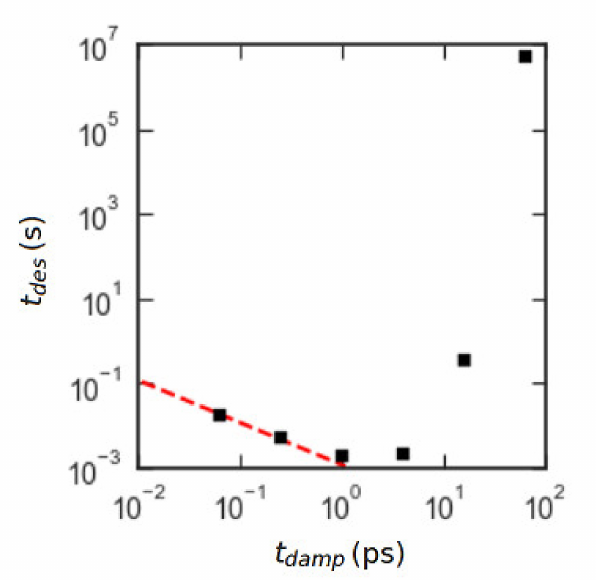
Figure 5. Plot of mean desorption times t des calculated with forward flux sampling for a series of freely jointed chains (FJCs) with N = 50, ε PW = 0.6 kJ / mol and with varying damping time t damp for fixed particle mass of 45 gm / mol. Black squares are forward flux sampling (FFS) data, and the red dashed line has slope − 1 on the log-log plot to illustrate the inverse scaling of t des with t damp as expected for non-inertial